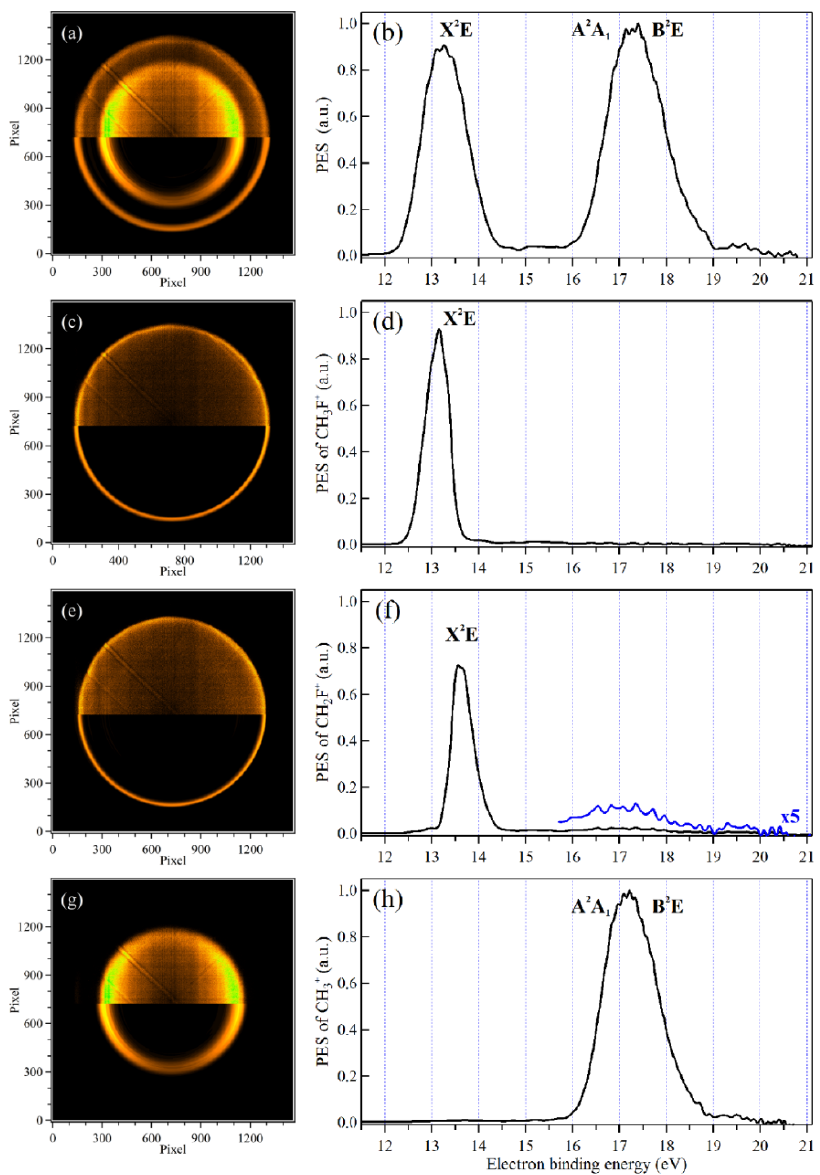
Figure 7. Mass-selected electron images and photoelectron spectra corresponding to ( a , b ) all ions, ( c , d ) the CH 3 F + parent ion, ( e , f ) the CH 2 F + fragment ion, and ( g , h ) the CH 3+ fragment ion, with 5-times-magnified data in blue, partially adapted with permission from Ref. [43]. Copyright 2017 American Chemical Society.